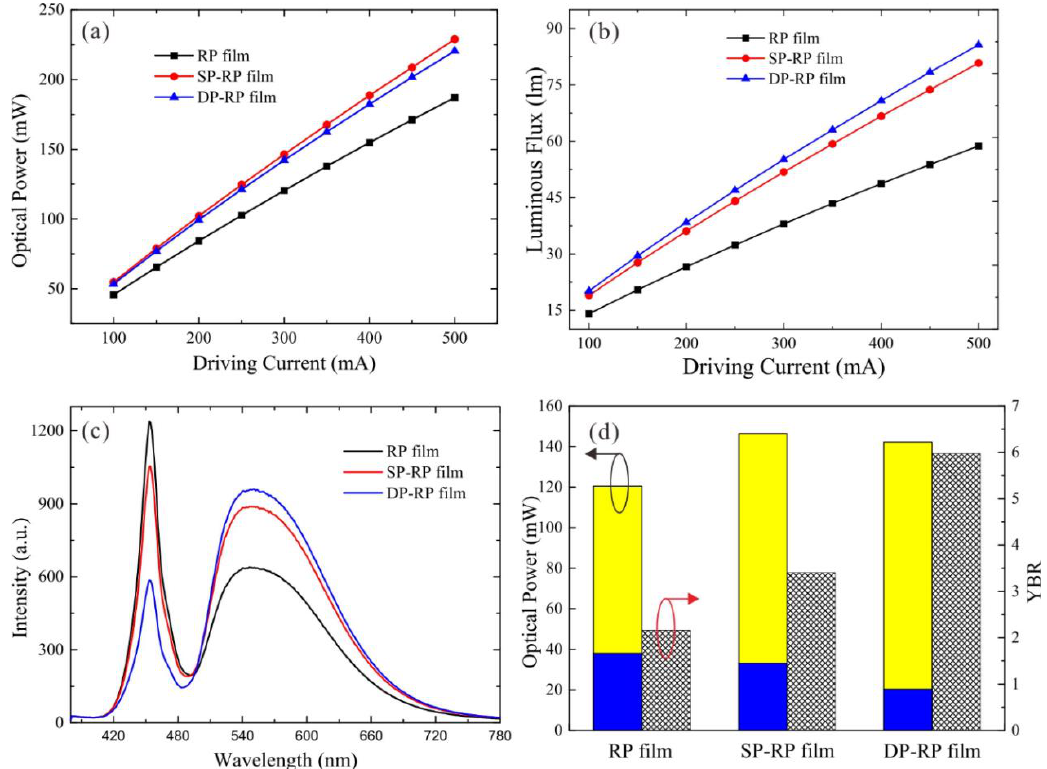
Figure 2. ( a ) Optical power and ( b ) luminous flux of the three remote phosphor-converted light-emitting diode (rpc-LED) devices at varying driving currents from 100 mA to 500 mA; ( c ) emission spectra of three rpc-LED devices at 300 mA and ( d ) their blue, yellow power and yellow-blue ratio (YBR) values.